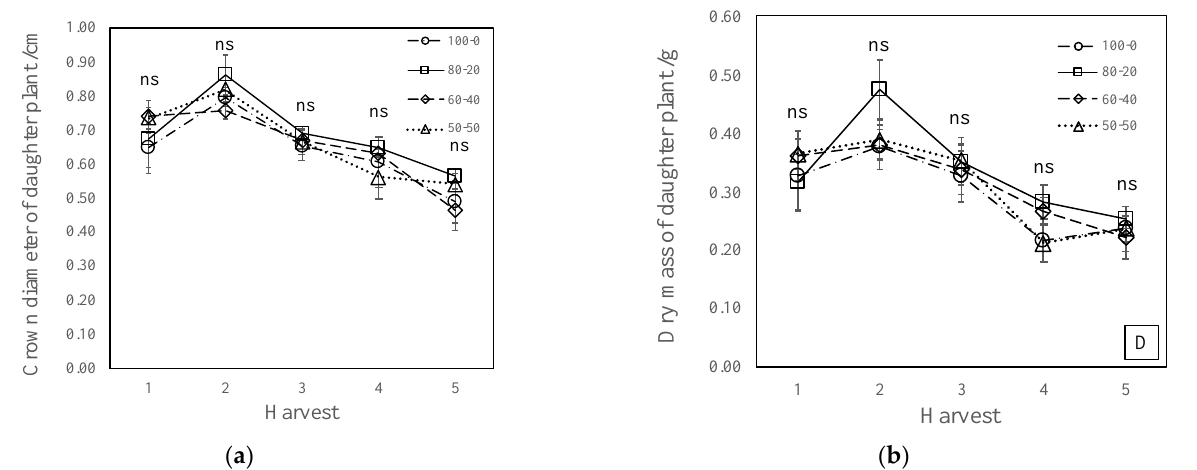
Figure 3. Average crown diameter and dry mass of daughter plants over five harvest days across the four treatments. ( a ) Average crown diameter (cm) of daughter plants harvested in all treatments. Shown are the mean and standard error. No significant difference was found. ( b ) Average dry mass (g) over five harvest days across the four treatments. Shown are the mean and standard error. No significant differences were found.